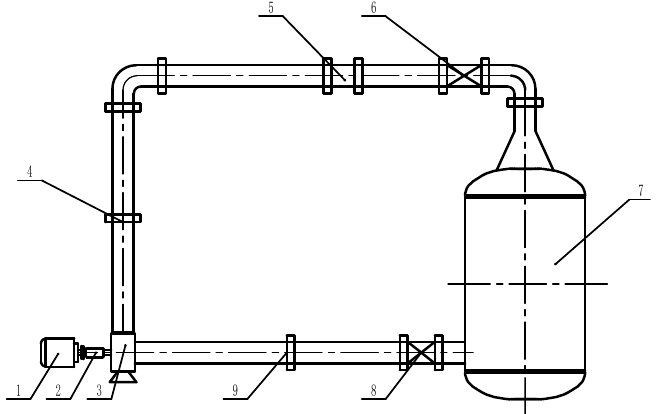
Figure 5. Schematic diagram of the test rig. 1. Motor; 2. torque meter; 3. centrifugal pump; 4. outlet pipeline pressure section; 5. DN100 electromagnetic flowmeter; 6. outlet pipeline valve; 7. water tank;